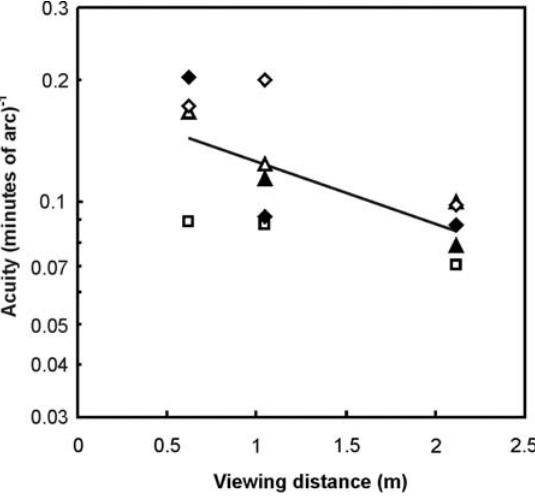
Figure 3. Effect of viewing distance on visual acuity of five great cormorants. The relationship is significant: log(acuity)= 2 0.751–0.151 (viewing distance). Symbols represent individual birds: m , n , X , e , % . Mean values 6 SEM: 0.15 6 0.03, 0.12 6 0.03, and 0.087 6 0.006 (minutes of arc) 2 1 for viewing distances of 0.62, 1.05, and 2.12 m, respectively